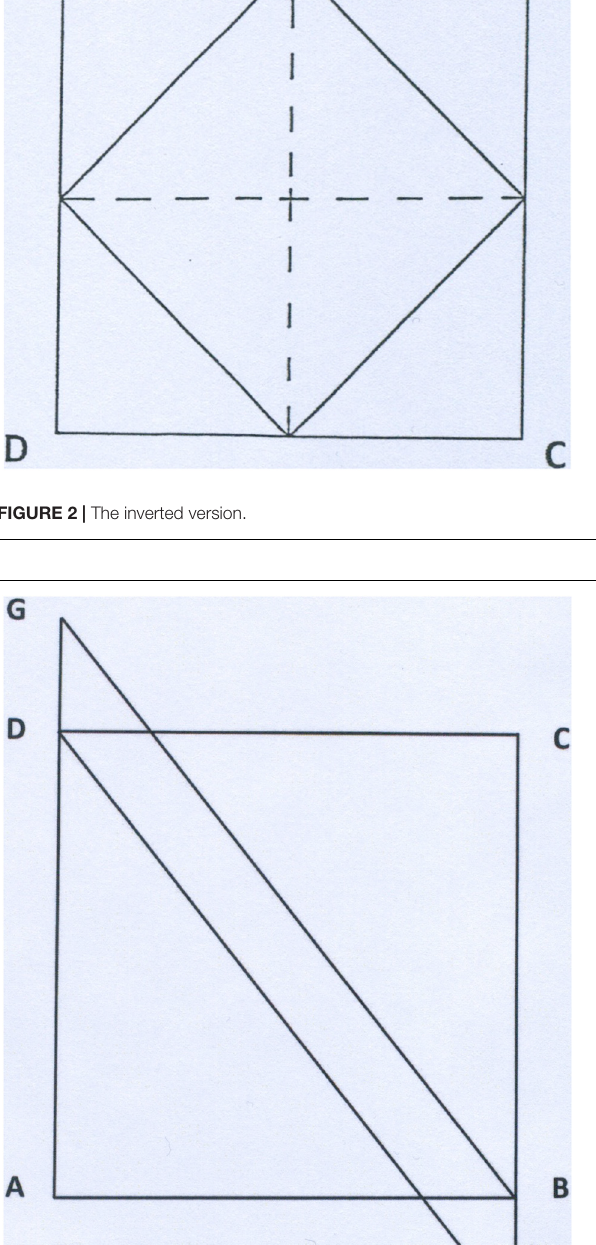
Even before this difficulty, so to speak, operational, the text of the problem is difficult because in it the quantity relative to the decrease of P. remains implicit ( − 5). The resulting